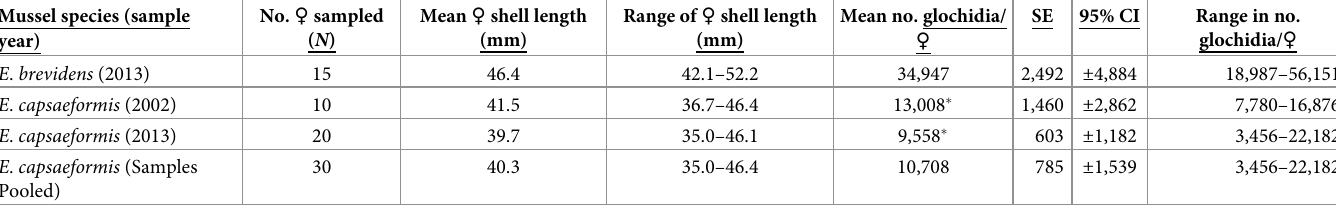
Table 5. Estimated fecundity of female Epioblasma brevidens and E . capsaeformis sampled from the Clinch River, TN in May–2013 and female E . capsaeformis sam- pled from the Clinch River, TN, in May 2002 and May 2013. Data from 2002 are in [10]. Fecundity was estimated by counting the number of glochidia in gravid female ( ♀ ) mussels. SE = Standard error of glochidia per ♀